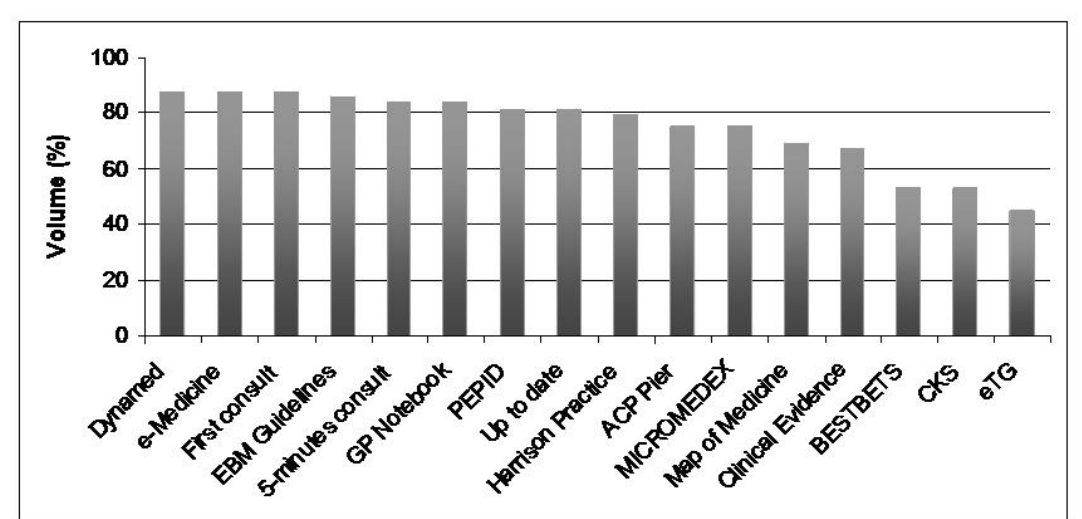
Figure 3. EBP point-of-care summary provider volume estimated on four random chapters of the ICD-10